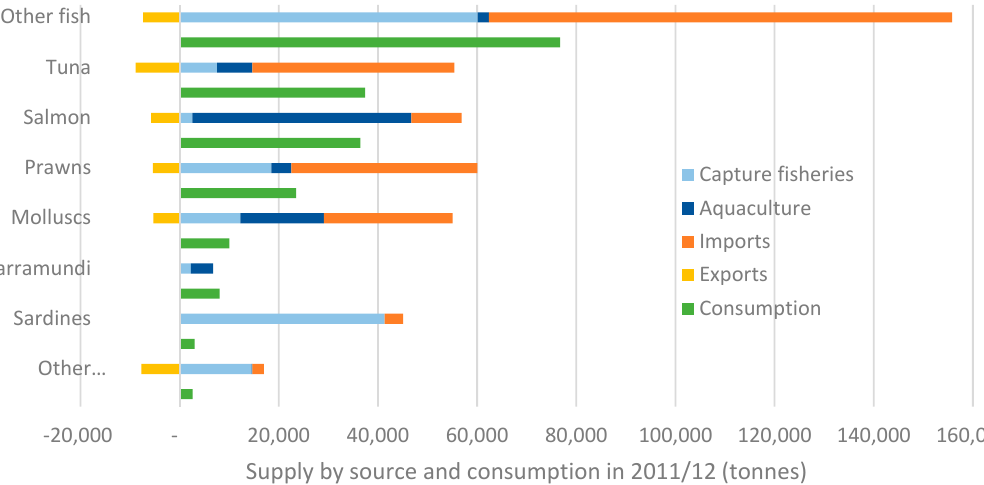
Figure 2. Australian consumption and supply of major fish and seafood types by production source in 2011/2012 (tonnes).